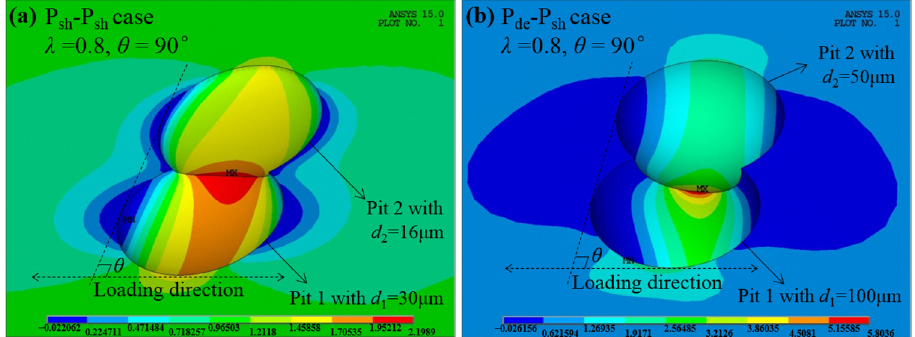
Figure 4. The comparison of stress contours with different pit depths. ( a ) d 1 = 30 μ m, d 2 = 16 μ m; and ( b ) d 1 = 100 μ m, d 2 = 50 μ m. The units of stress in this and the subsequent figures are MPa.